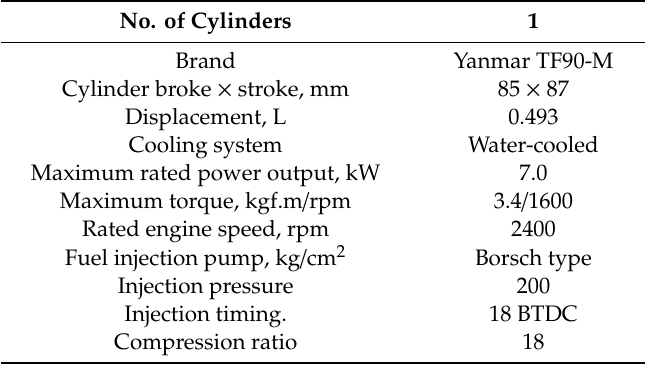
Table 1. Specifications of the diesel